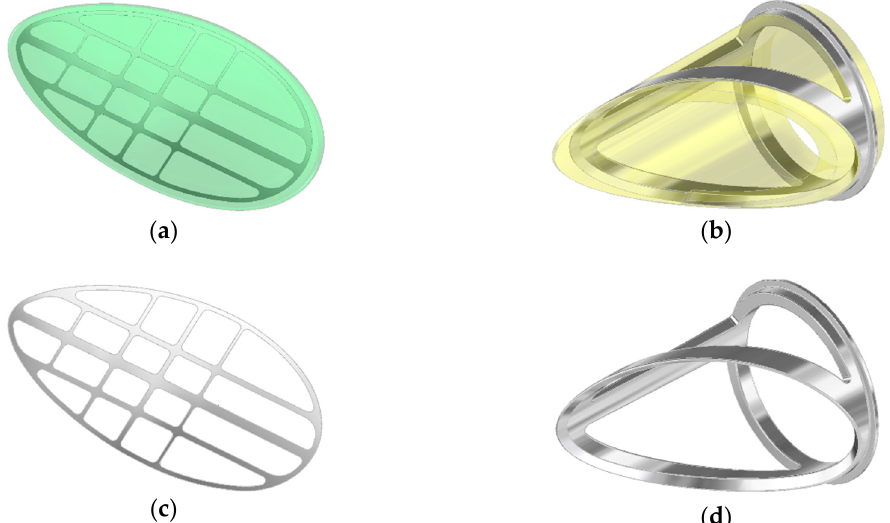
Figure 2 . Inflow valve construction details: ( a ) composite leaflet, ( b ) polyurethane valve ring, ( c ) open-shape frame, ( d ) the metal frame.